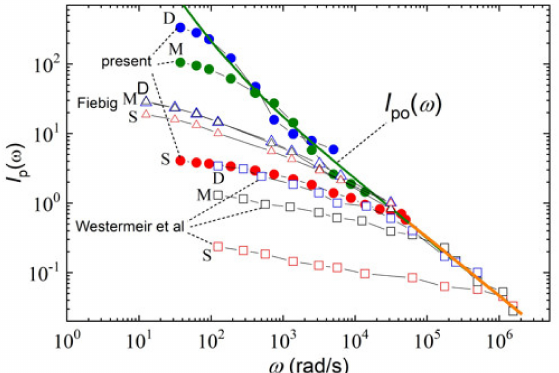
Figure 7. Photocurrent I p ( ω ) spectra as a function of the angular modulation frequency of FETs from different laboratories. The I p ( ω ) signal is shown for probe laser illumination near the source (S), midway between the source and drain (M), and near the drain side (D). I p ( ω ) signal derived by digitizing the SPCM I p (x) profiles of different modulation frequencies reported by Westermeir et al. [12] (open squares) and Fiebig [22] (open triangles). The I p ( ω ) spectra of the present work (solid circles) are taken from Figure